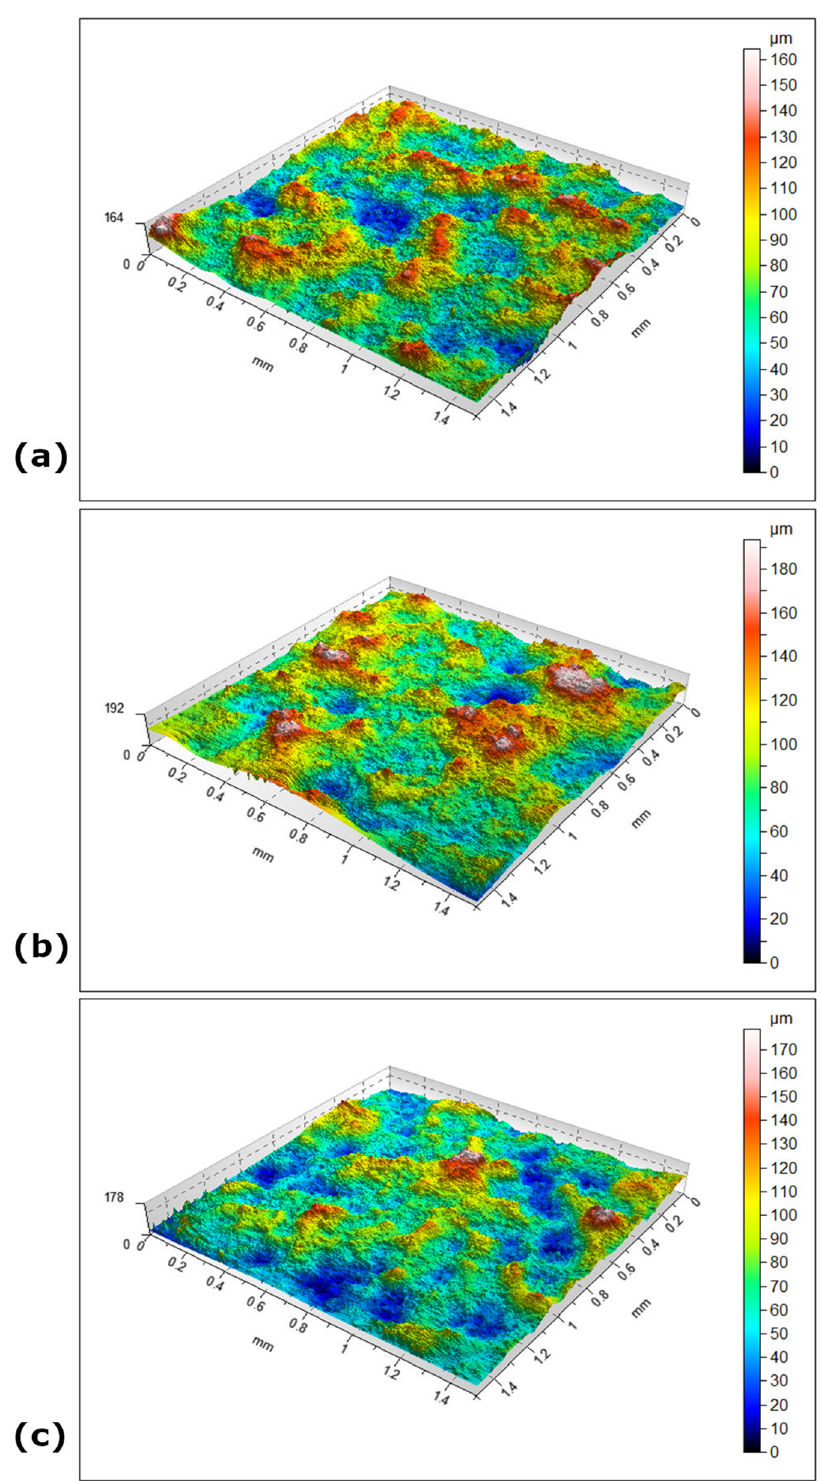
Figure 7. Surface geometry of hydroxyapatite coatings ( a ) HA 1, ( b ) HA 2 ( c ) HA 3. Flatness of the surface, or kurtosis (Sku), increased with increasing spraying distance and degree of powder remelting. It can result in thermal effects on the substrate. Highest (Sp) points increased with spraying distance, but the shallowest (Sv) point value was clearly greater for the HA2 sample. Sz parameters were calculated from the absolute high ‐ est and lowest points.